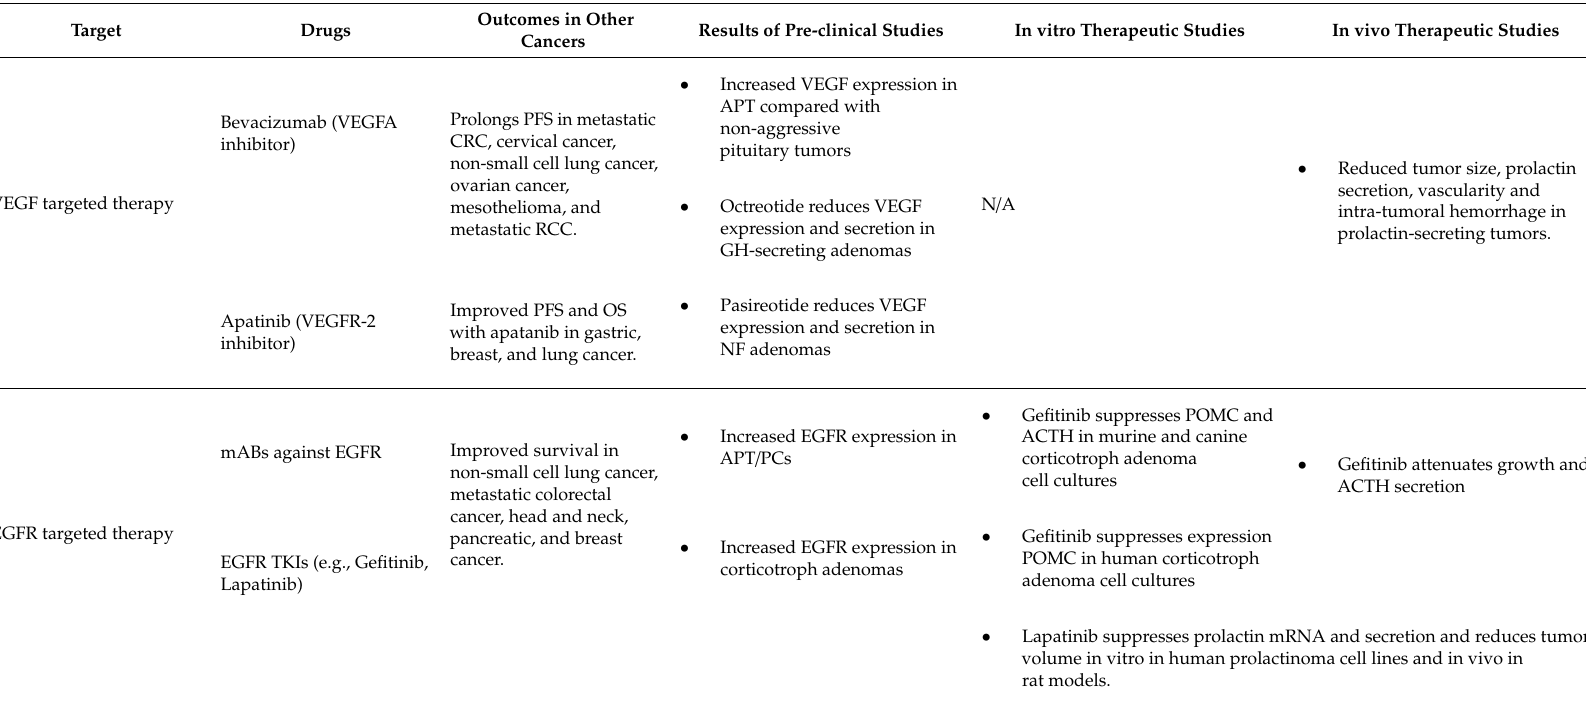
Table 2. Overview of targeted therapy for aggressive pituitary tumours and pituitary carcinomas. Therapeutic targets, established drugs, outcomes in other cancers, evidence from pre-clinical studies relating to therapeutic targets in pituitary tumors, and in vitro and in vivo studies of targeted therapy in pituitary